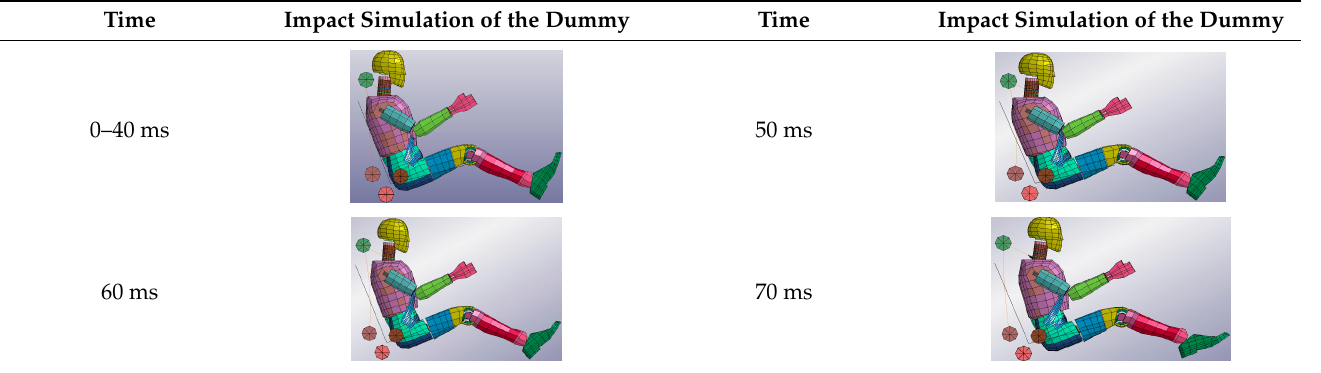
Table 5. Dummy simulation of the frontal collision in the armored vehicle, from 0 to 120 ms.